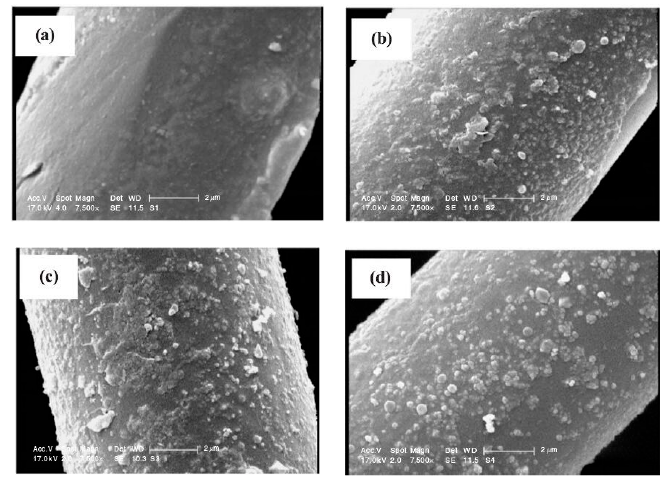
Figure 5. SEM images from surfaces that were plasma-treated with subsequent deposition. ( a